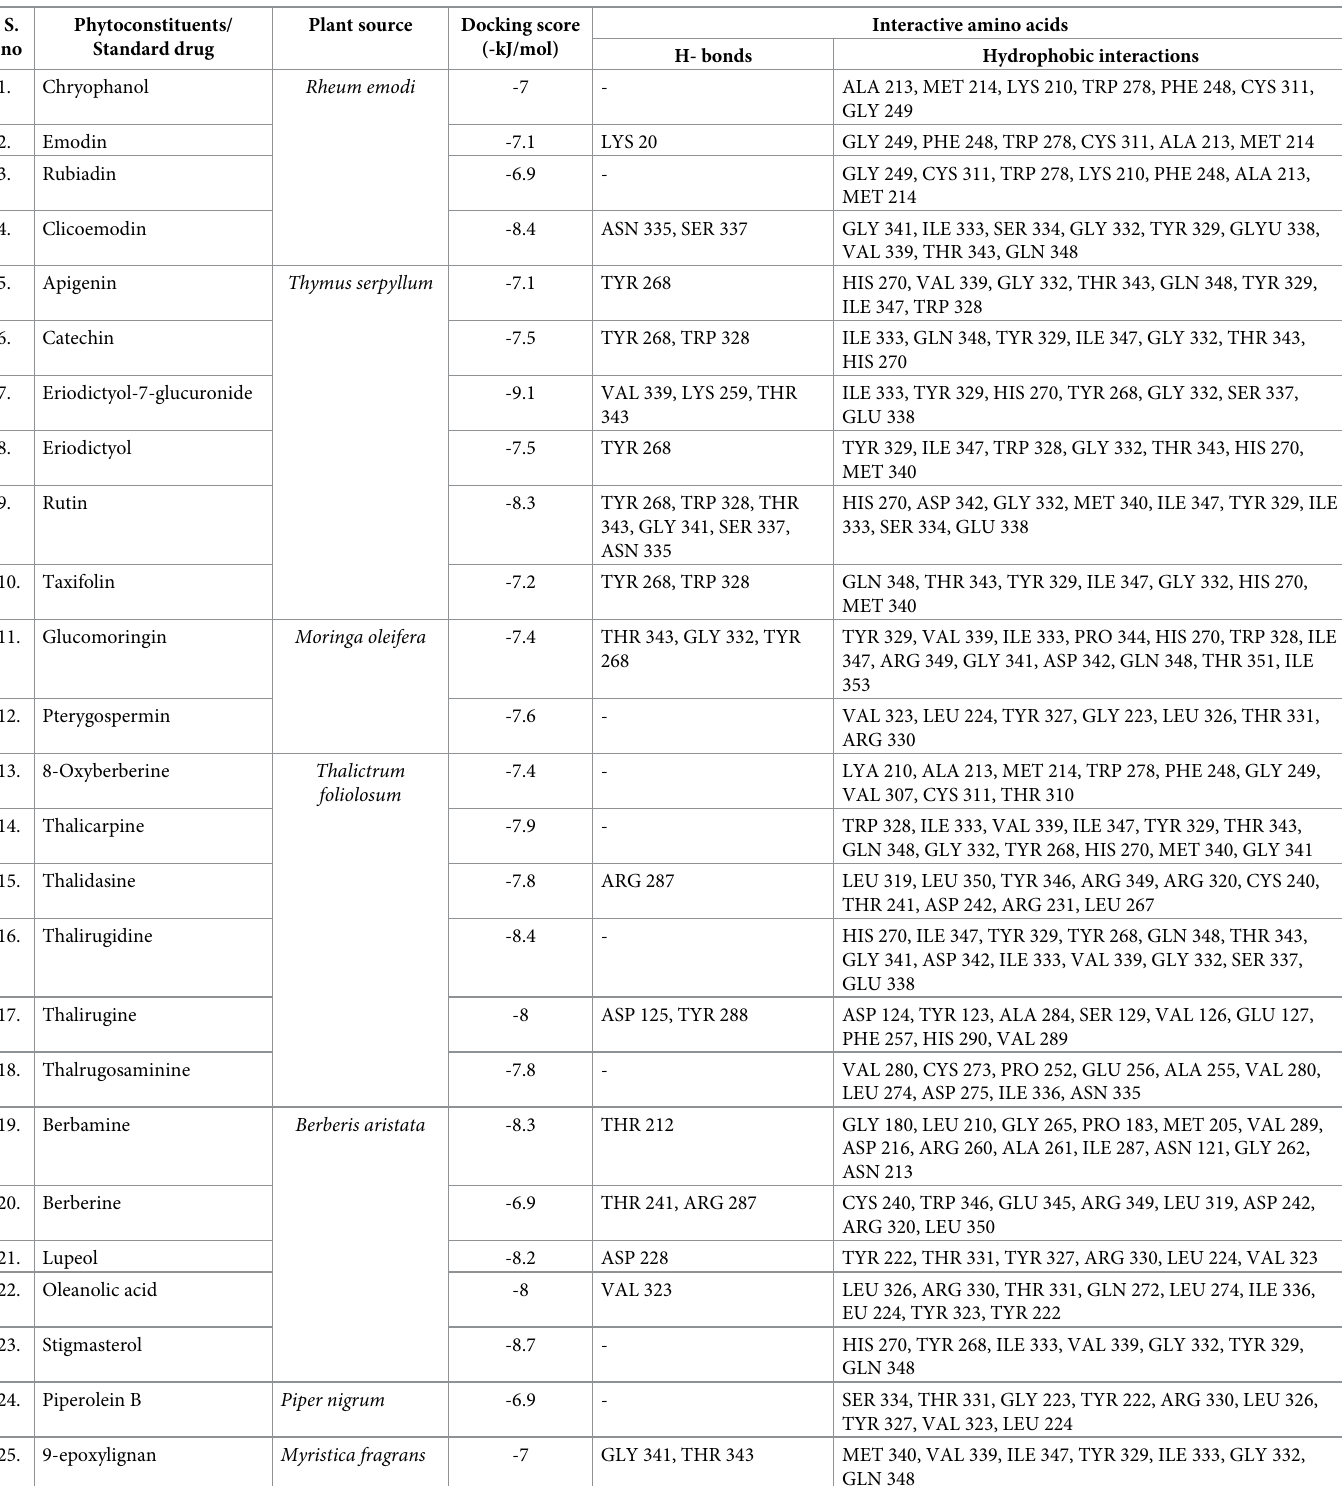
Table 2. The table exhibits important bioactive phytoconstituents of herbal plants their docking with HPV-18 (1R9W) and interactive amino